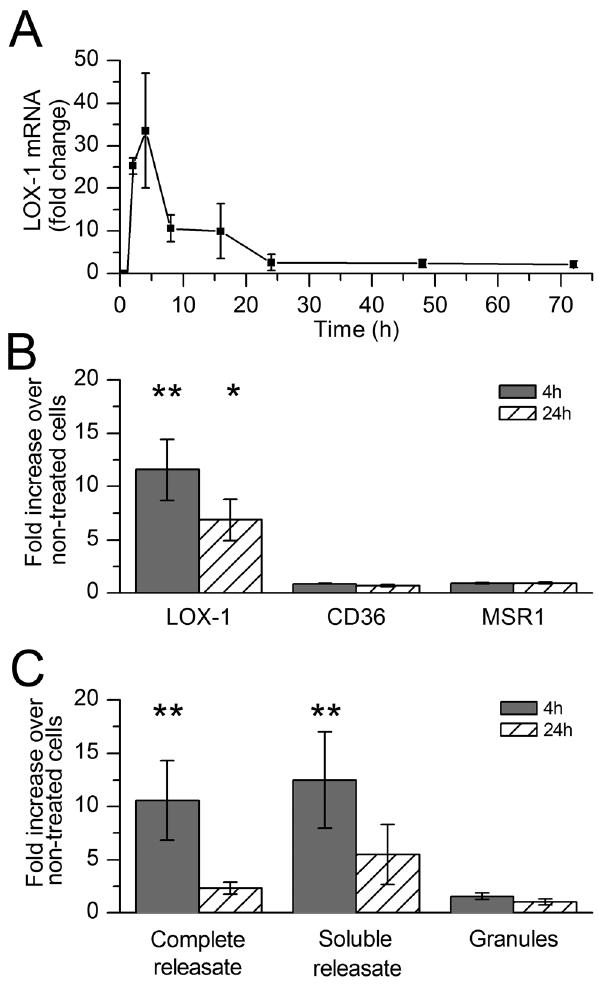
Figure 1.Time-dependent mast cell releasate-induced changes in macrophage scavenger receptor mRNA expression. A) Monocyte-derived macrophages (MDM) from 3 donors were cultured in human primary mast cell releasate for 72 h, and LOX-1 mRNA expression was analyzed and compared to non-treated cells at the beginning of the incubation. B) MDMs from 6 donors were cultured in LAD2 mast cell releasate for 4 h and 24 h, and LOX-1, CD36 and MSR1 mRNA expression was measured and compared to non-treated cells at each time point. C) MDMs from 3 different donors were incubated in complete releasate, soluble releasate, or granules derived from LAD2 mast cells for 4 h and 24 h. The results are presented as means 6 SEM. *p , 0.05, **p , 0.01 vs. non-treated